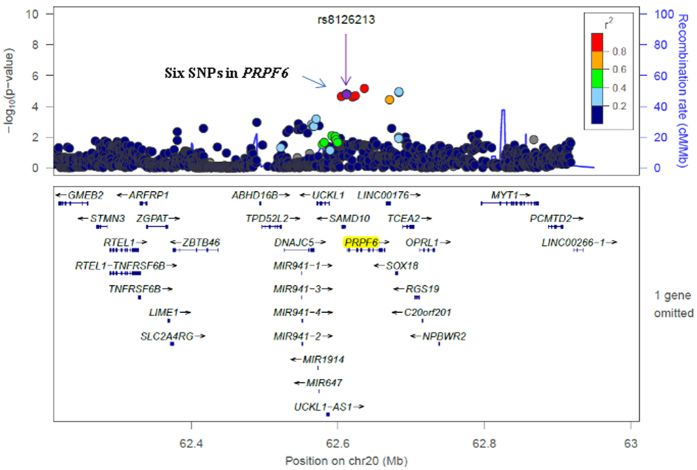
Regional plots and recombination rates of PRPF6 (rs8126213 ± 500 kb) in the TRICL Consortium.PRPF6 rs8126213 was shown in purple and the linkage disequilibrium (LD) values (r2) with the other SNPs are indicated by the heat scale. Other five PRPF6 SNPs are shown in red color, which meant that they were in high LD with rs8126213 (r2 > 0.8).